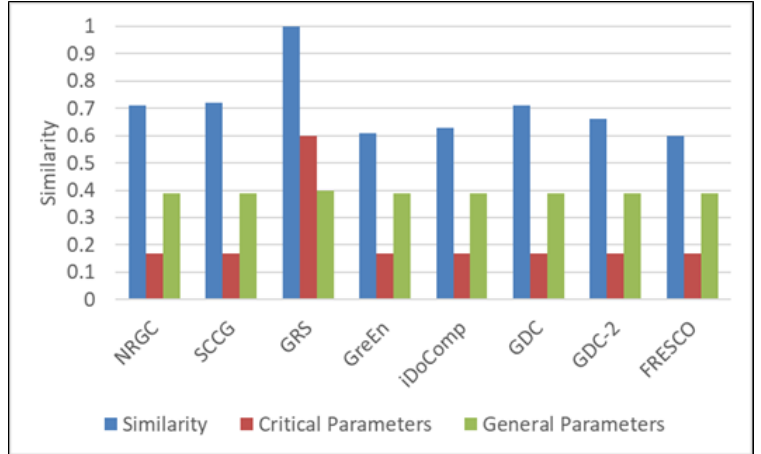
Figure 5. Similarity and weighting results of genome referential algorithms.